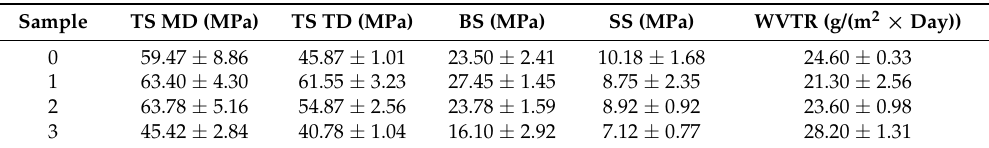
Table 1. Tensile strength in machine direction (TS MD), tensile strength in transversal direction (TS TD), burst strength (BS), seal strength (SS) and Water Vapor Transmission Rate (WVTR) of pure PLA and PLA/melanin modified